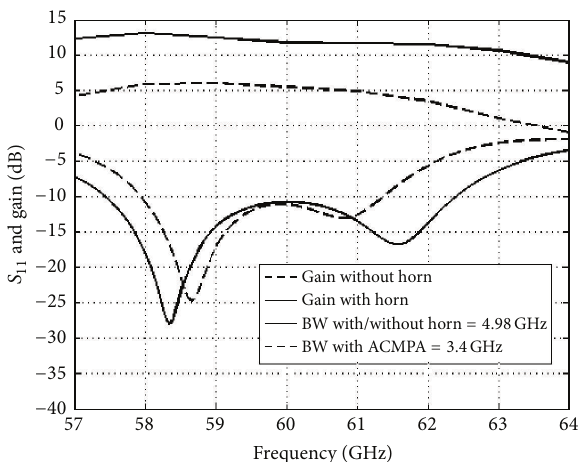
Figure 4: Comparison of gain and bandwidth of ACMPA with and without